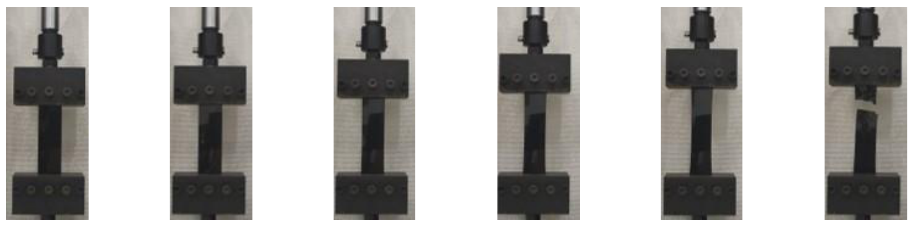
Figure 13. The tension process of a PET specimen.